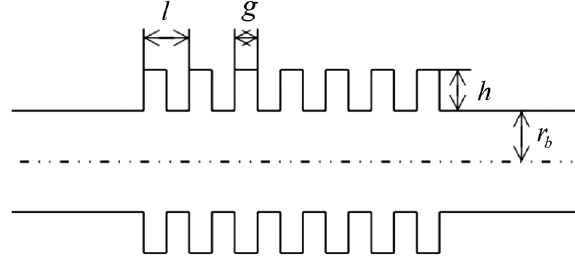
FIG. 4. A schematic view of bellows.